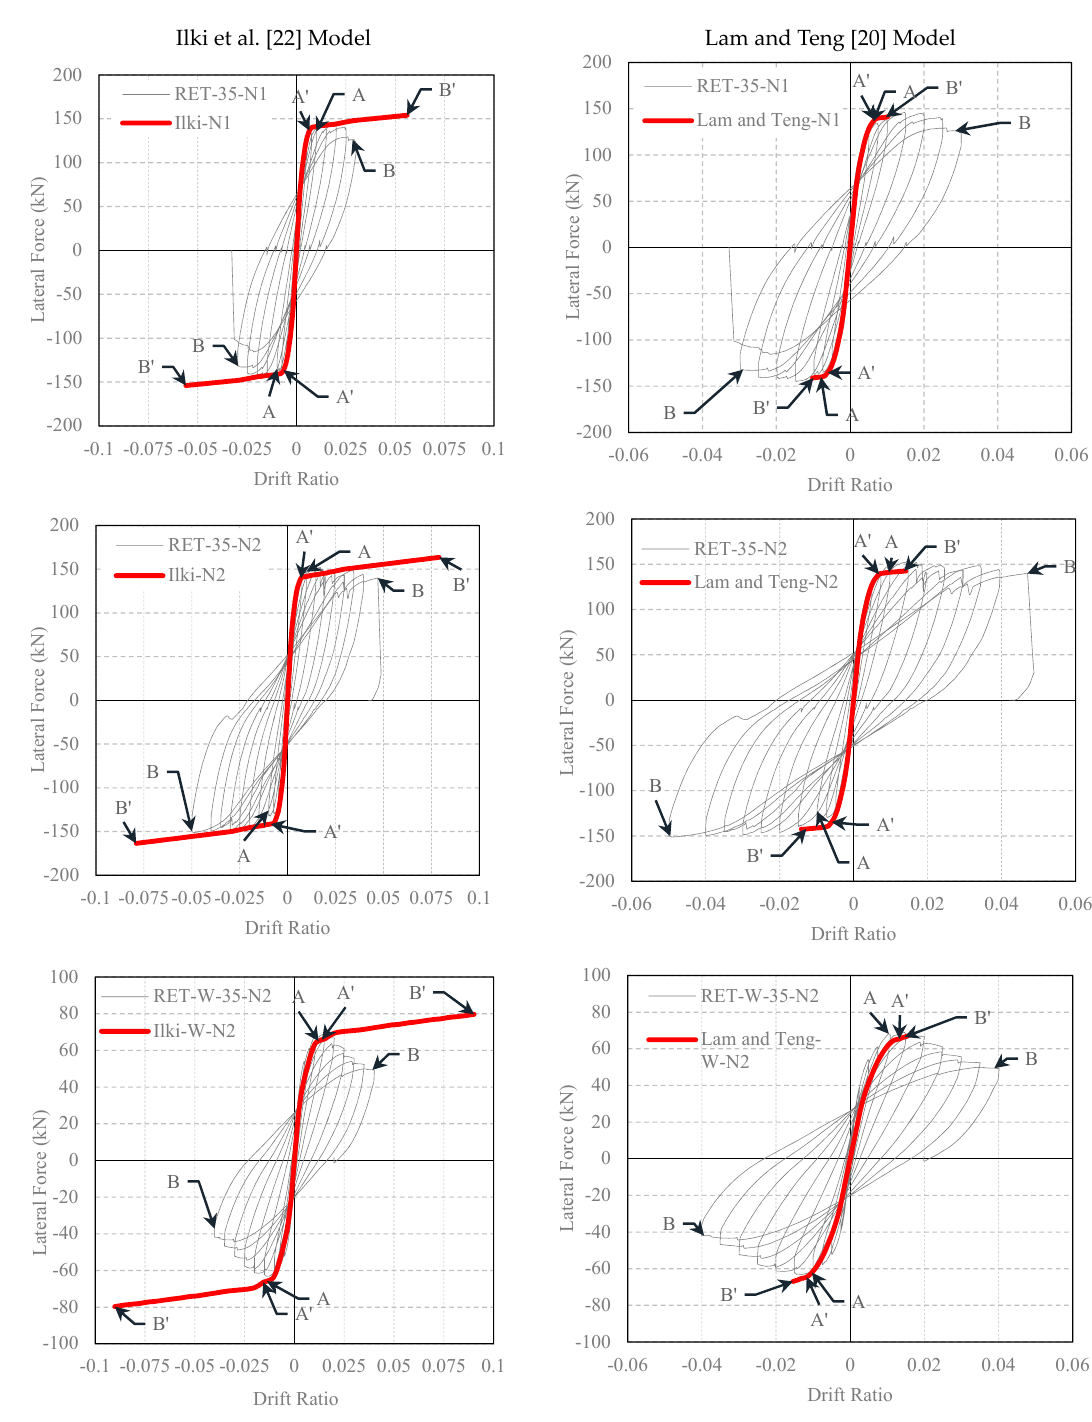
Figure 11. Comparison of experimental and analytical lateral load-drift relationships (confined concrete strength and strain capacity obtained by using Ilki et al. [22] and Lam and Teng [20] models).